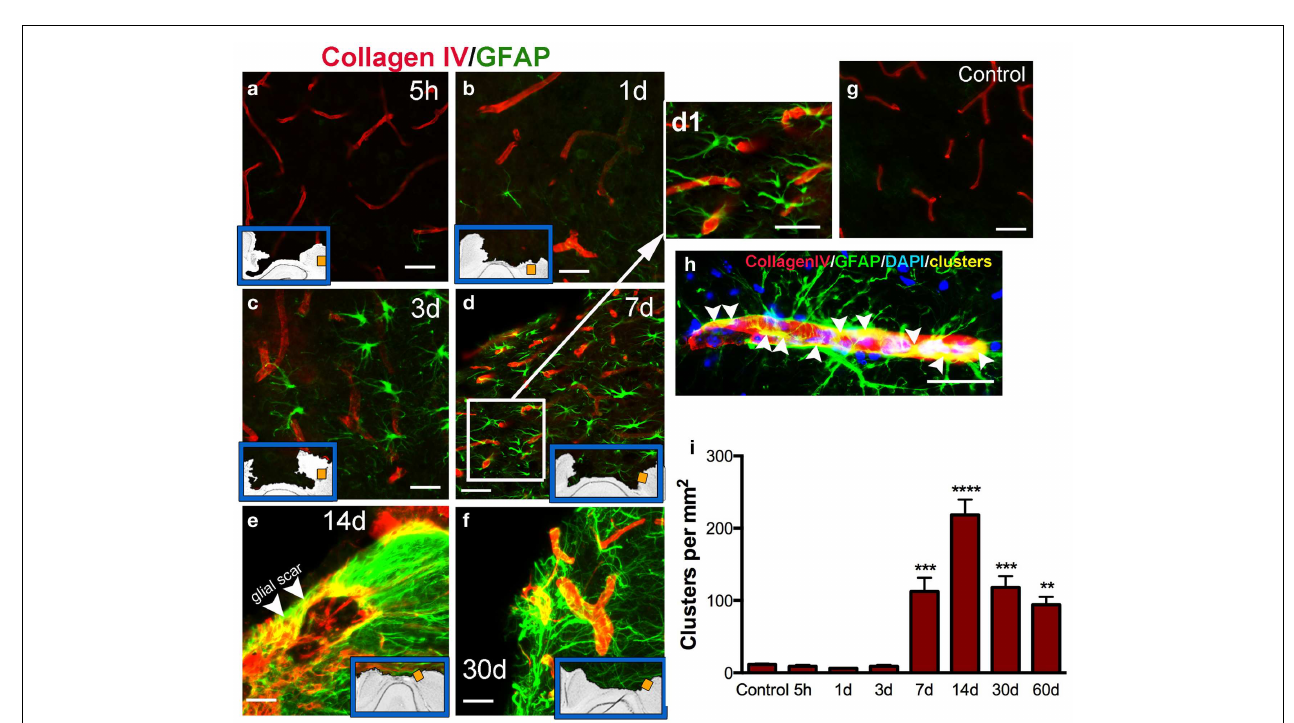
Shows the interaction of blood vessels and astrocytes. Integration of their respective stains results in yellow colocalization (called clusters). (i) Density of clusters (measured in pixels per area) in the pericontusional regions of the cortex. Clusters are first detected at 7dpi, and peak at 14dpi.Values are expressed as mean ± SEM, n = 3–5 per group, ** p < 0.01, *** p < 0.001, *** p < 0.0001 compared to control